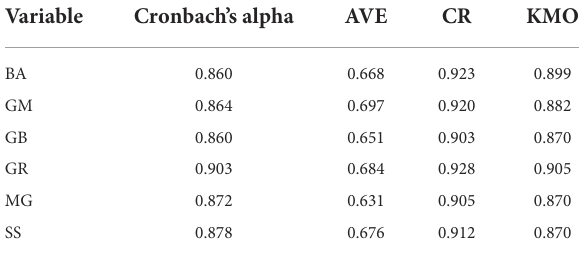
TABLE 5 Measurement items, loadings, validity and